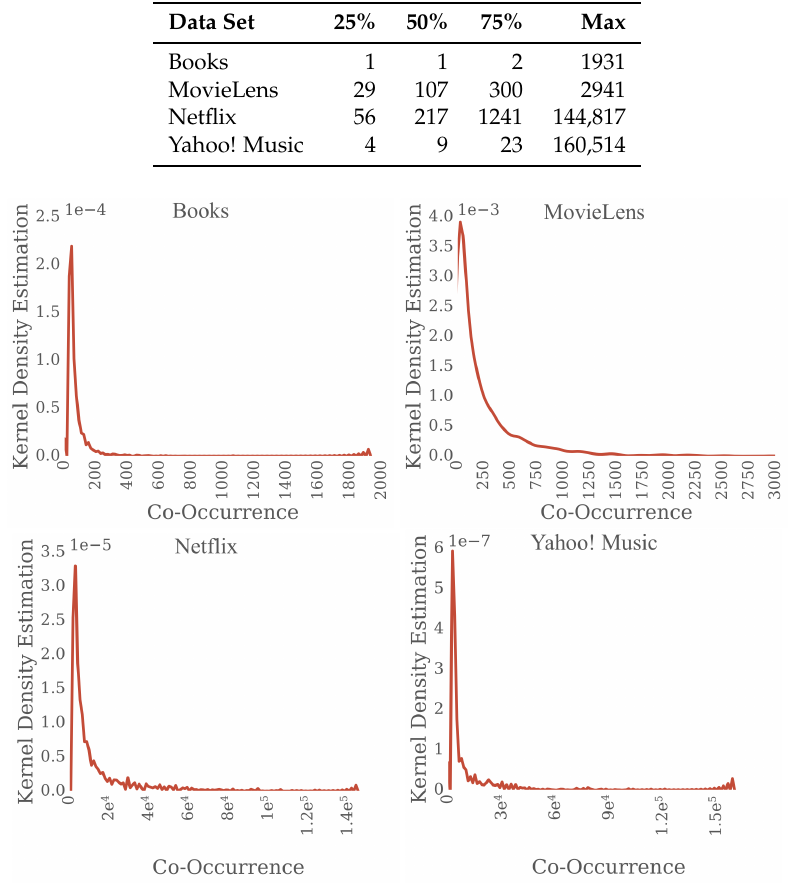
Figure 5. The Kernel Density Estimation function of the item co-occurrence concentrates at infrequent values.